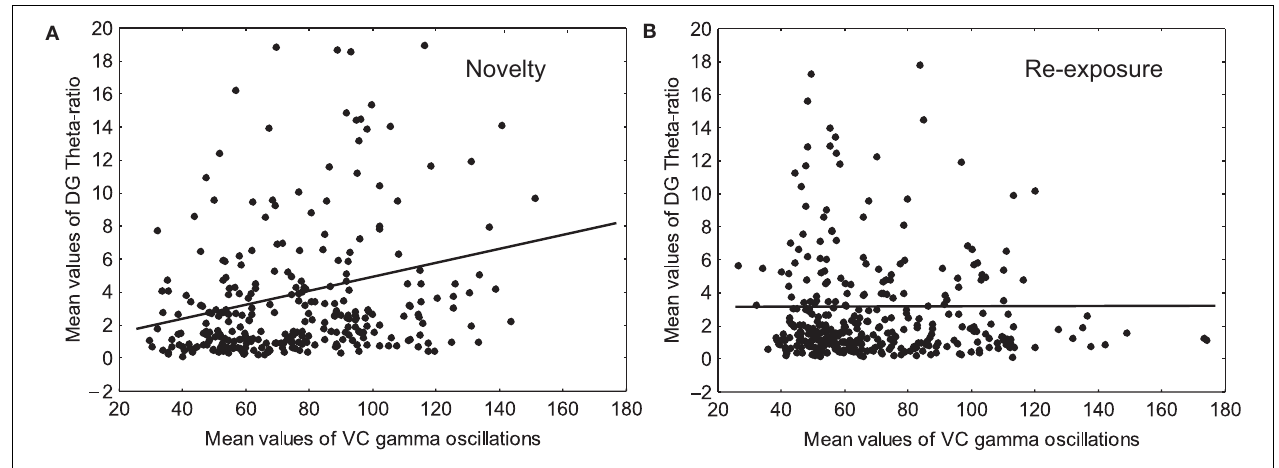
FIGURE 2 | Gamma oscillations in the visual cortex and theta-ratio in the dentate gyrus correlate during novelty exploration. (A) Signifi cant (Pearson, n = 4, p < 0.0001, r = 0.2266) values between visual cortex (VC) gamma oscillations